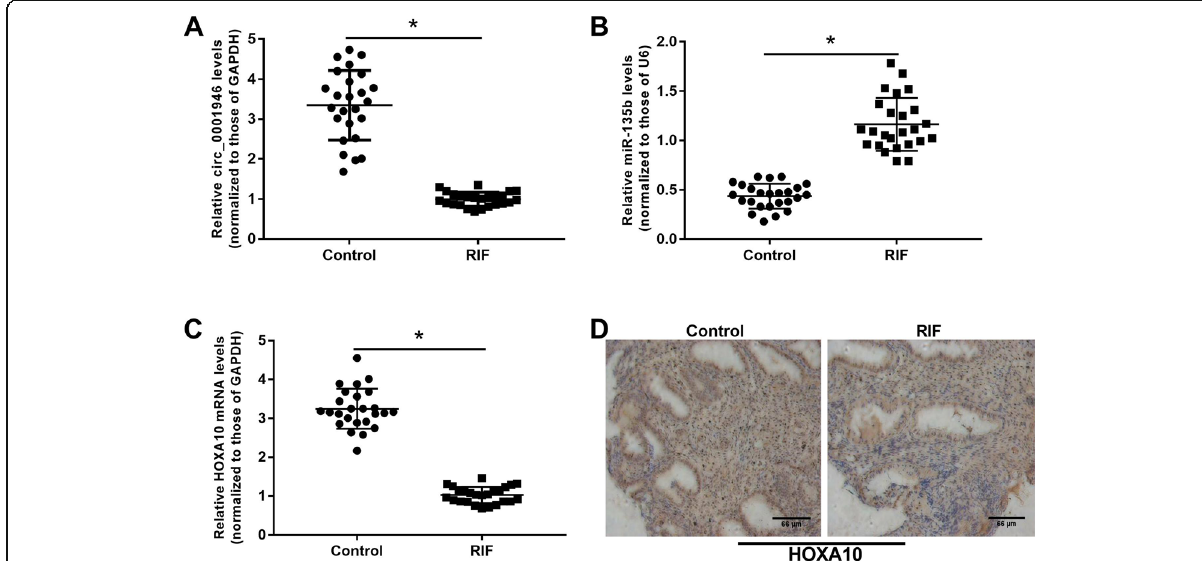
Fig. 1 Expression profiles of hsa_circ-0001946, miR-135b, and HOXA10 in tissues from women undergoing in vitro fertilization-embryo transfer treatment. a-c. Quantitative RT-PCR for the expression of hsa_circ_001946, miR-135b, and HOXA10 in tissues from women undergoing in vitro